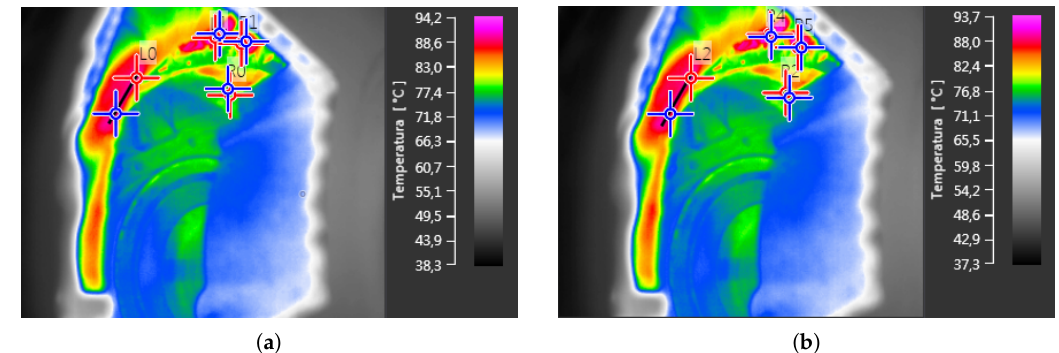
Figure 17. Thermal pictures acquired with thermal camera Workswell WIC 336 (frame rate 30 Hz) of IPM-SM rotor at PWM frequency of 4 kHz: ( a ) thermocouples on stator winding; ( b ) thermocouples on permanent-magnets. The number of thermocouples is consistent with Figure